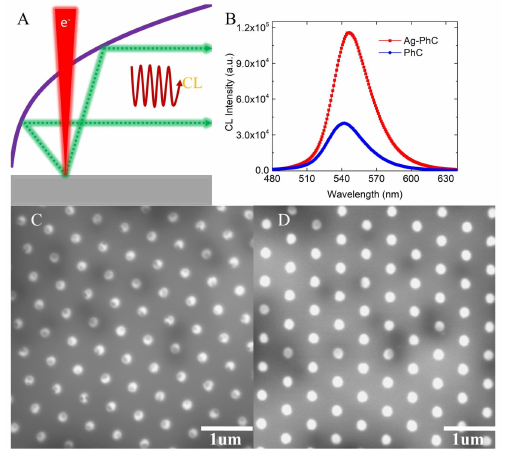
Figure 3. ( A ) Schematic setup for the cathodoluminescence (CL) measurement; ( B ) CL spectra for Ag–PhC and PhC samples. Panchromatic CL images for ( C ) the Ag–PhC sample and ( D ) the PhC sample. CL intensity for the Ag–PhC sample is enhanced 2.91 times compared with that for PhC sample.